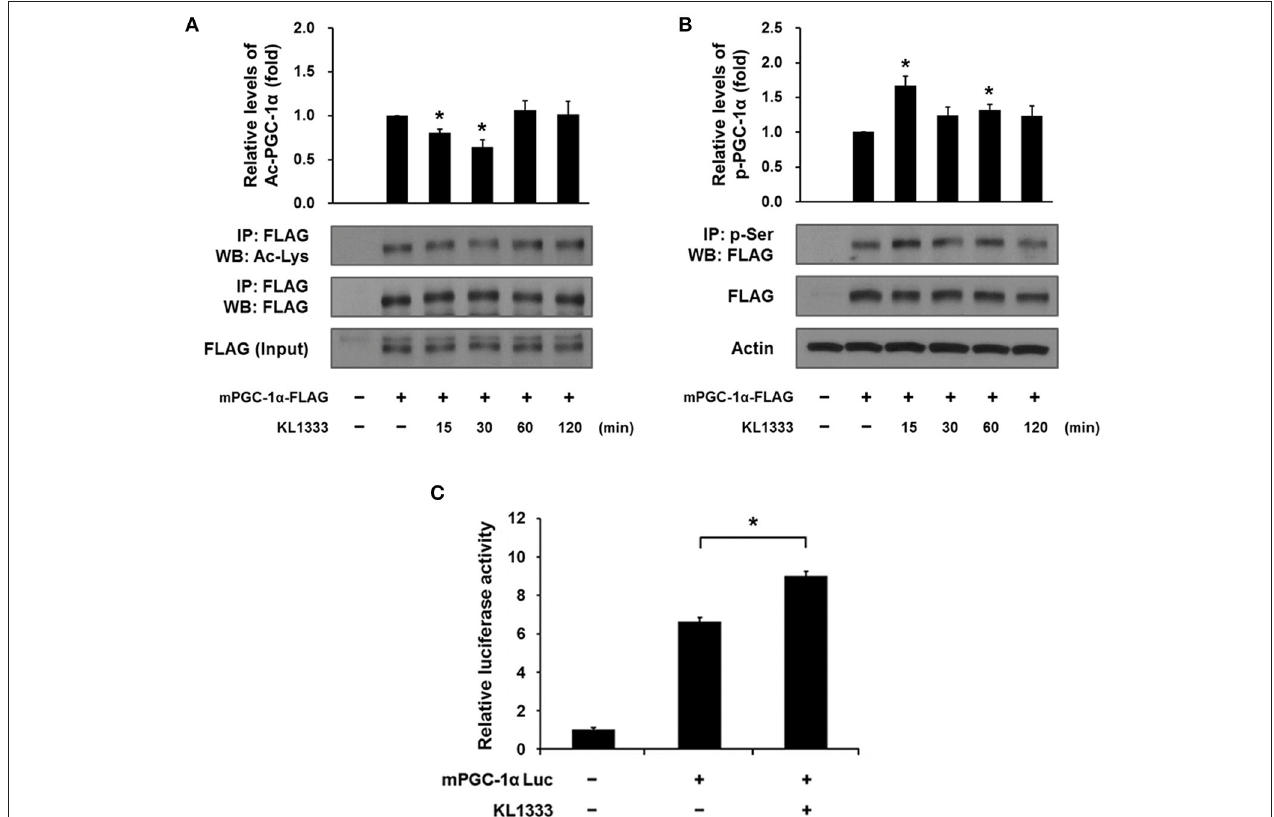
FIGURE 4 | KL1333 induces PGC-1 α activation. (A) C2C12 myoblasts were transfected with FLAG-tagged mPGC-1 α for 48h, and then treated with 2 µ M KL1333 for the indicated times. Cell lysates were subjected to immunoprecipitation using antibody against FLAG. The acetylation levels of PGC-1 α were examined by Western blotting using anti-acetyl lysine antibody. Histograms show the levels of acetylation of PGC-1 α relative to total FLAG-tagged mPGC-1 α under each of the indicated conditions. The experiment was repeated three times. (B) C2C12 myoblasts were transfected with FLAG-tagged mPGC-1 α for 48h, and then treated with 2 µ M KL1333 for the indicated times. Cell lysates were subjected to immunoprecipitation using antibody against phospho-serine. The phosphorylation levels of PGC-1 α were examined by Western blotting using an anti-FLAG antibody. Histograms show the levels of phosphorylation of PGC-1 α relative to total FLAG-tagged mPGC-1 α under each of the indicated conditions. The experiment was repeated three times. (C) Cells expressing PGC-1 α luciferase were treated with 1 µ M KL1333 for 24h. Cell lysates were subjected to luciferase assays, and the activity of the PGC-1 α promoter was analyzed. The experiment was repeated four times. Error bars indicate ± SEM. * P <